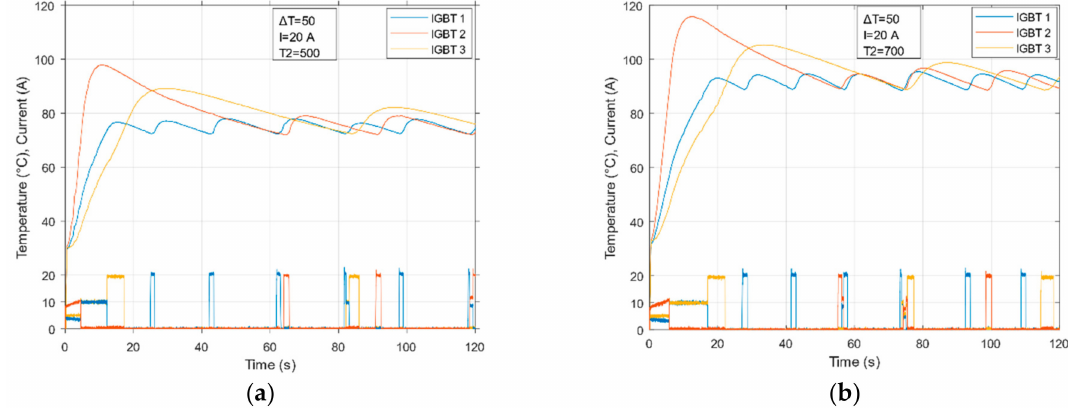
Figure 11. Upper threshold temperature ( T 2 ) influence on three paralleled IGBTs for ( a ) T 2 = 74 ◦ C; ( b ) T 2 = 90 ◦ C.